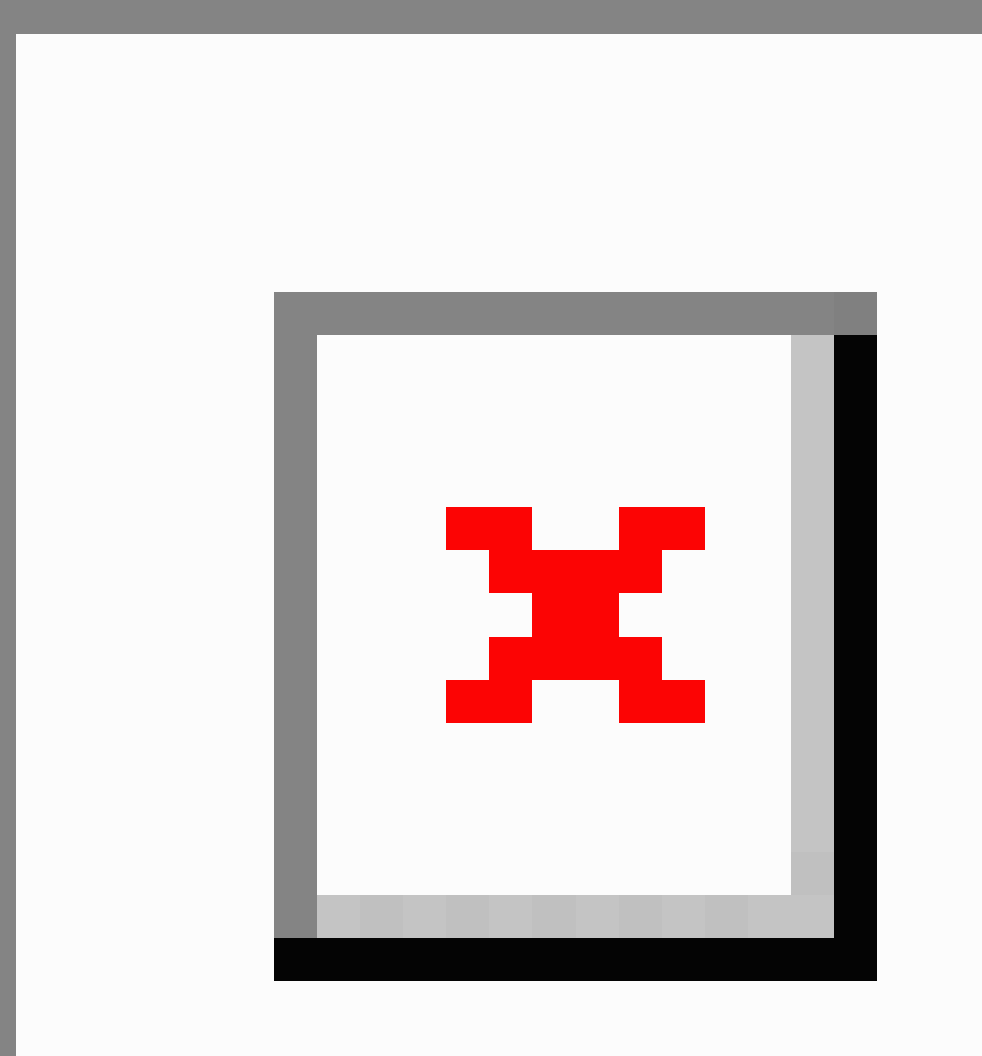
Figure 1. Screenshots of mobile apps which were downloaded on the smartphones prior to the